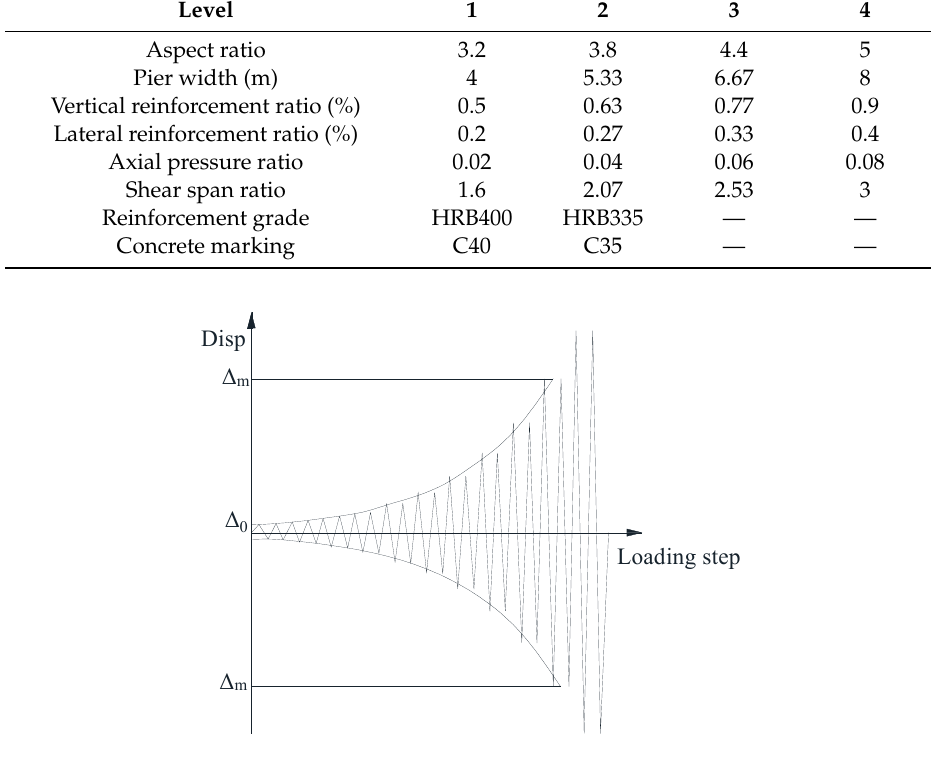
Figure 4. Loading process of displacement control.